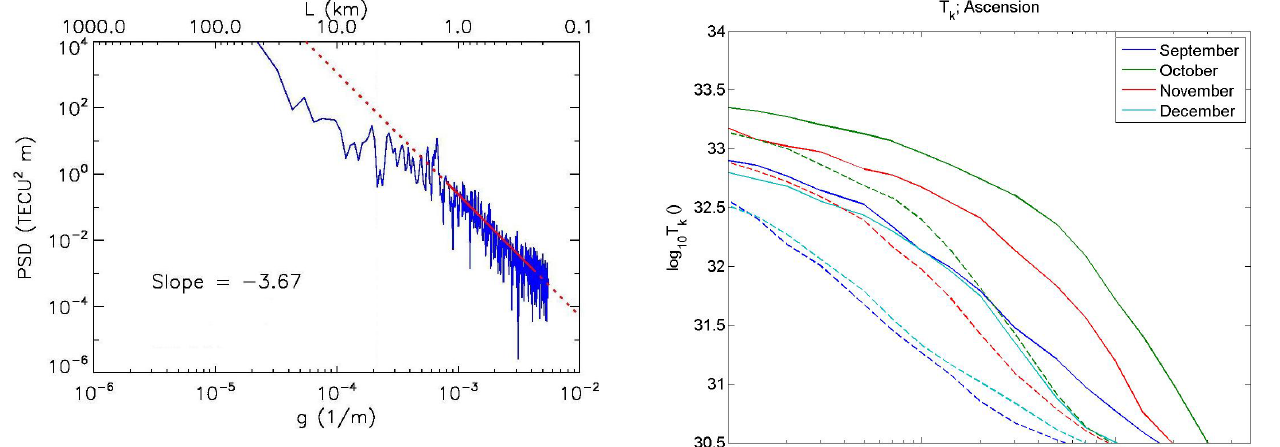
Fig. 1. Spatial spectrum of TEC irregularities, line fitted to the steep high-frequency part, and slope of the fitted line. This spectrum was measured at 22:45LT, on 26 October 2004. Fig. 2. CDF of log 10 T k over Ascension in four months of autumn 2004. Dashed lines: total time; solid lines: only